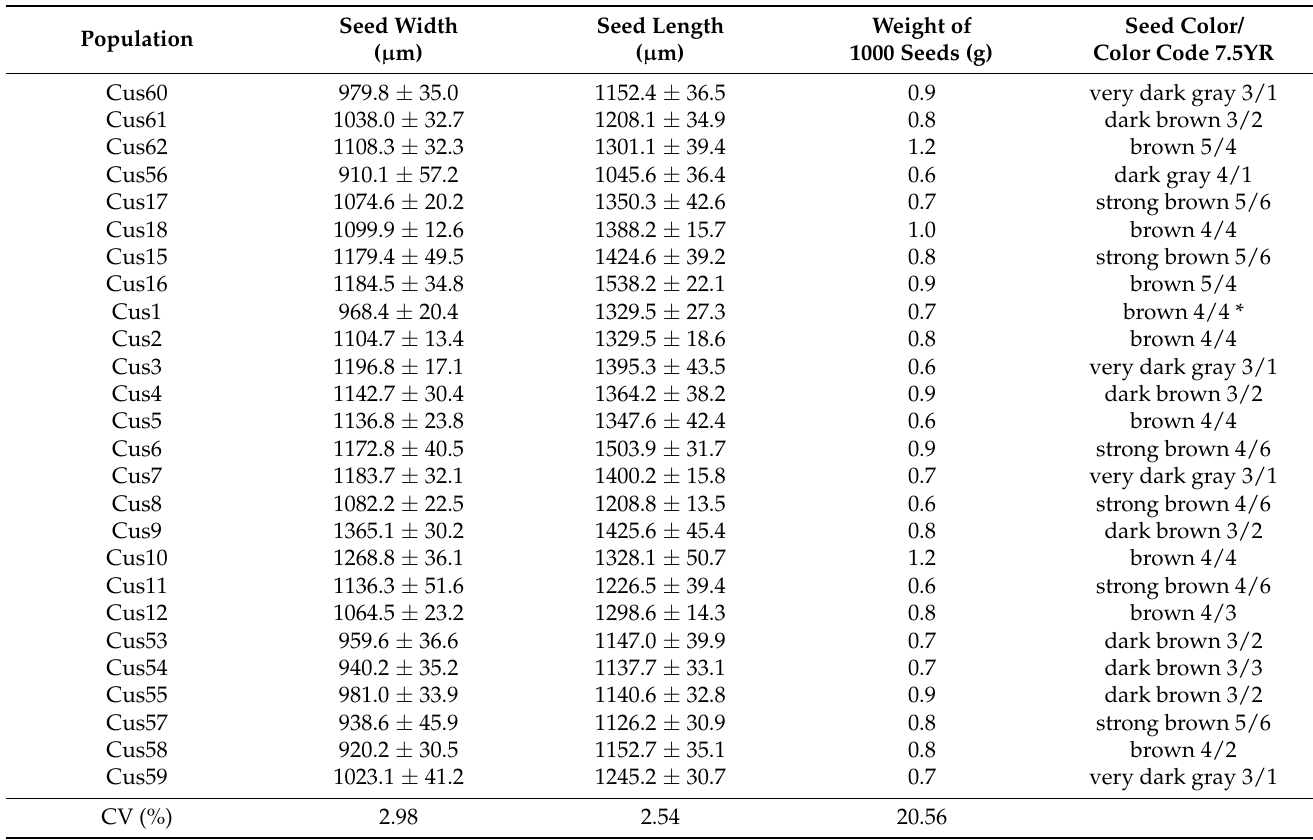
Table 2. Morphological traits of C. campestris